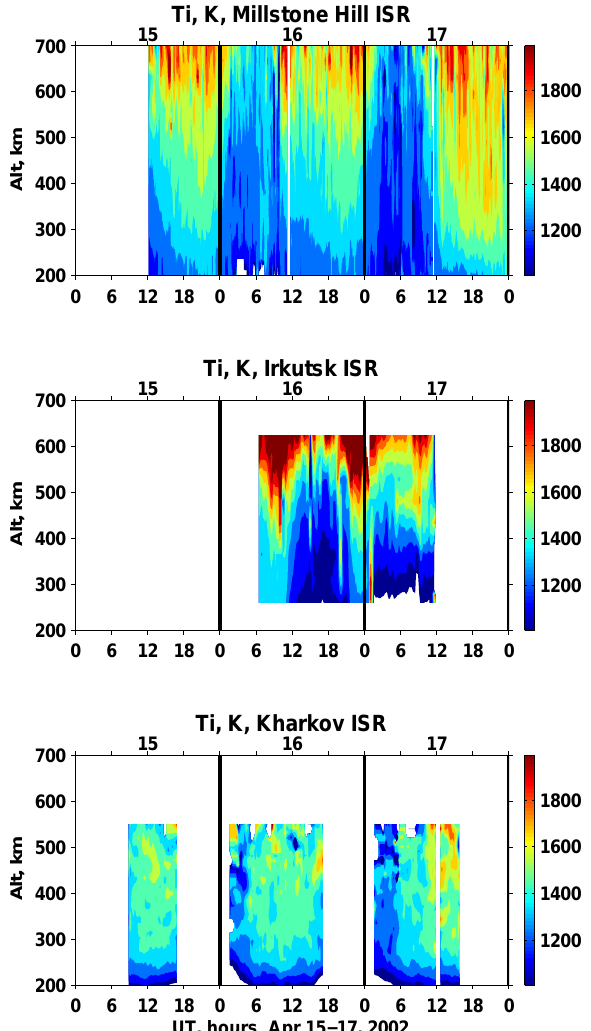
Fig. 8. Variations in ion temperature on 15–17 April 2002 at mid-latitude locations Millstone Hill (top), Irkutsk (middle), and Kharkov